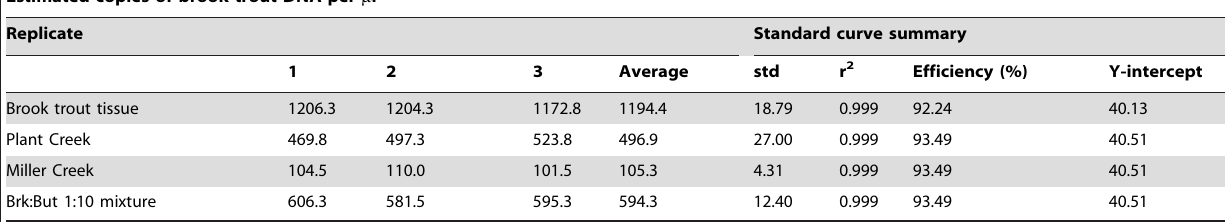
Estimated copies of brook trout DNA per m l